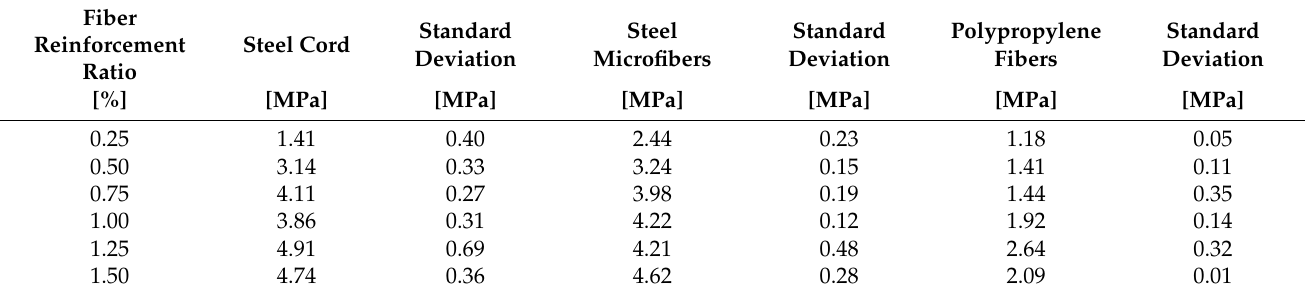
Figure 12. Load-deflection curve for specimens with polypropylene fibers. Table 4. Flexural toughness factor [60].